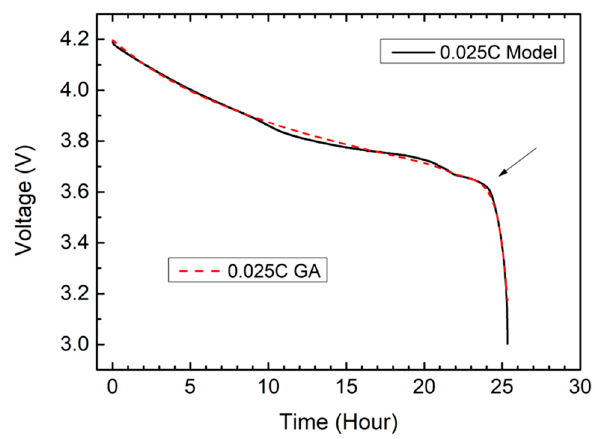
Figure 20. GA results (P brand 18650).